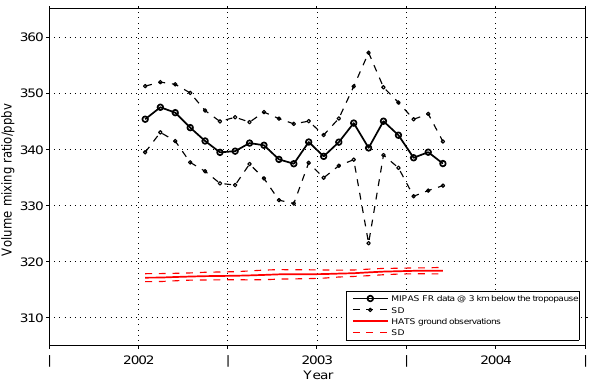
Figure 16. Comparison of CH 4 from ACE-FTS and MIPAS re- duced resolution (V5R_CH4_224 and V5R_CH4_225) at 60–90 ◦ N in February and March. Details as in Fig.